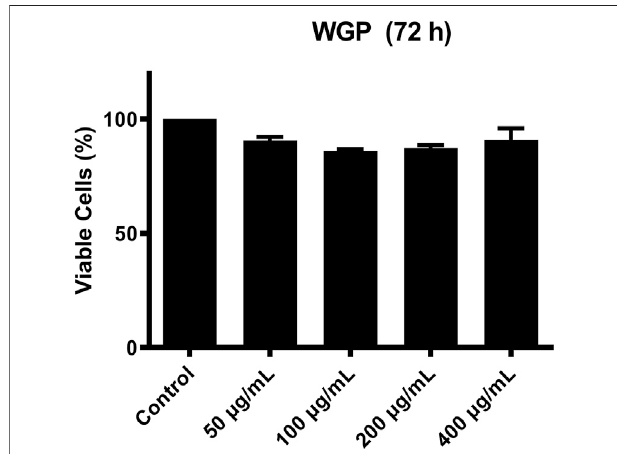
FIGURE 3 | WGP have minimal effect on the growth of hepatocytes. L-O2 cells were treated with WGP at a series of equal ratio gradient concentrationsfor72 hand thensubjectedtoMTTassay.Dataarepresented as mean ± standard errors of the mean (SEM) from 3 independent